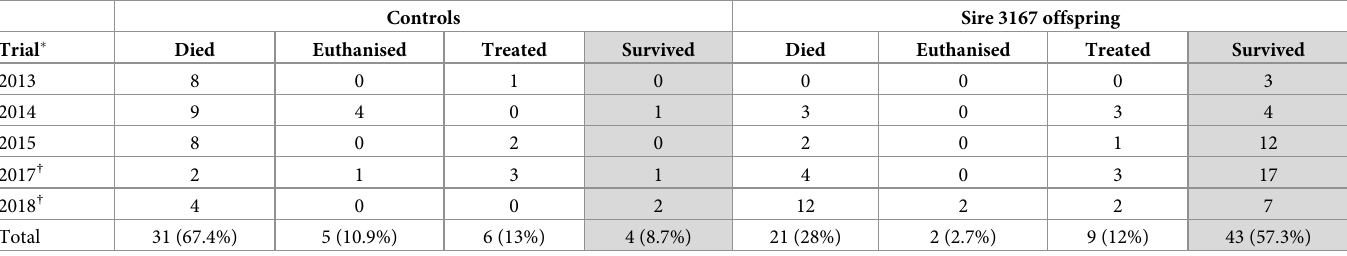
Table 1. Summary of survival outcomes for control and pedigree animals over the course of five field